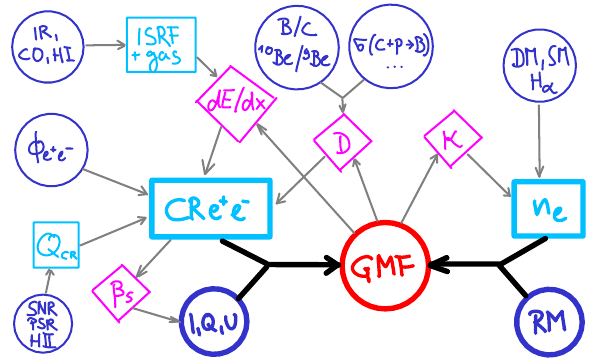
Figure 6. Sketch of the procedure to estimate the GMF from data (blue circles), models (azure squares) and auxiliary quanti- ties (magenta diamonds). See text for further